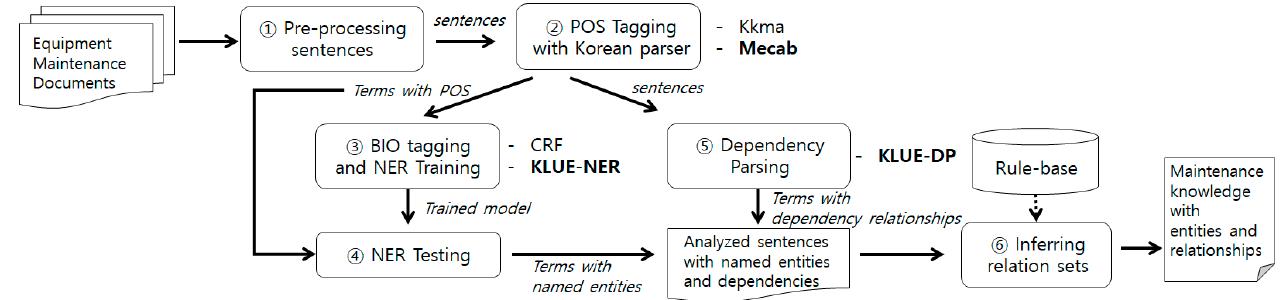
Figure 1. The proposed approach for relation set extraction.